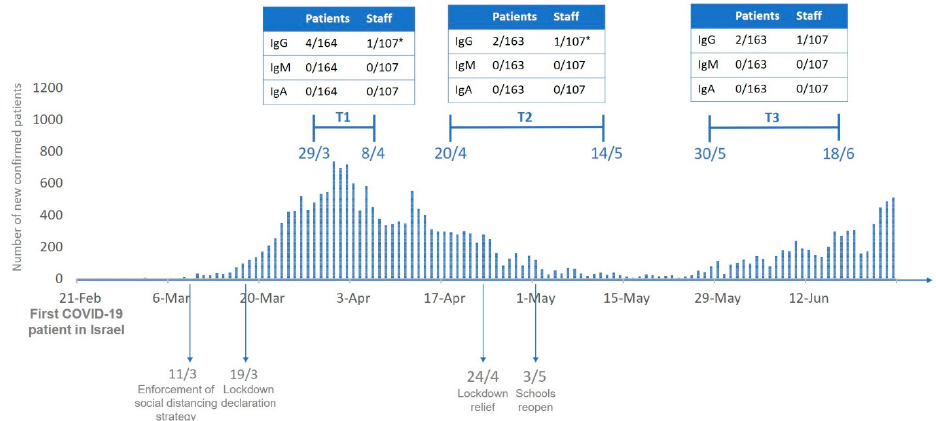
Figure 1. Scheme of the study timeline. * Different staff member at T1 and T2